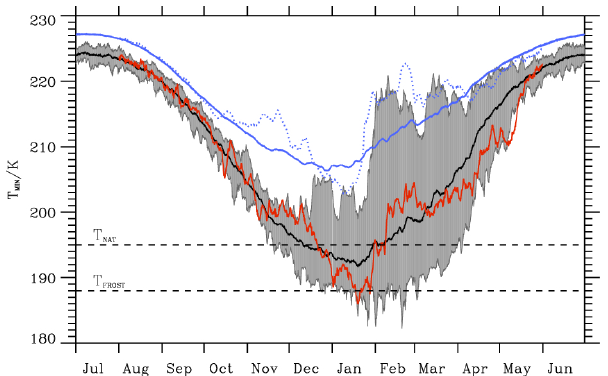
Figure 1: Minimum temperatures T MIN (K) between 65 °N to 90 °N at the 50 hPa pressure 3 Fig. 1. Minimum temperatures T MIN (K) between 65 to 90 ◦ N at surface: Black line denotes the mean value from 1989 – 2009, the red line the T MIN evolution 4 the 50hPa pressure surface: Black line denotes the mean value from August 2009 through May 2010; shaded area encompasses the minimum/maximum 5 from 1989–2009, the red line the T MIN evolution from August T MIN between 1989 and 2009. Blue solid line: climatological mean polar cap (50 °N – 90 °N) 6 2009 through May 2010; shaded area encompasses the mini- temperature T POLAR CAP ; dotted blue line: mean polar cap temperature from August 2009 7 mum/maximum T MIN between 1989 and 2009. Blue solid line: cli- through May 2010. Source: ECMWF reanalyses interim (ERA-Interim) data provided at 6 8 matological mean polar cap (50 to 90 ◦ N) temperature T POLARCAP ; hourly temporal resolutions, see: http://www.ecmwf.int. The PSC formation temperatures 9 dotted blue line: mean polar cap temperature from August 2009 T NAT and T FROST are calculated assuming volume mixing ratios of 5 ppm for water vapour and 10 through May 2010. Source: ECMWF reanalyses interim (ERA- 10 ppb for nitric acid trihydrate (NAT); Hanson and Mauersberger (1988). 11 Interim) data provided at 6 hourly temporal resolutions, see: http: //www.ecmwf.int. The PSC formation temperatures T NAT and T FROST are calculated assuming volume mixing ratios of 5ppm for water vapour and 10ppb for nitric acid trihydrate (NAT); Hanson and Mauersberger (1988).